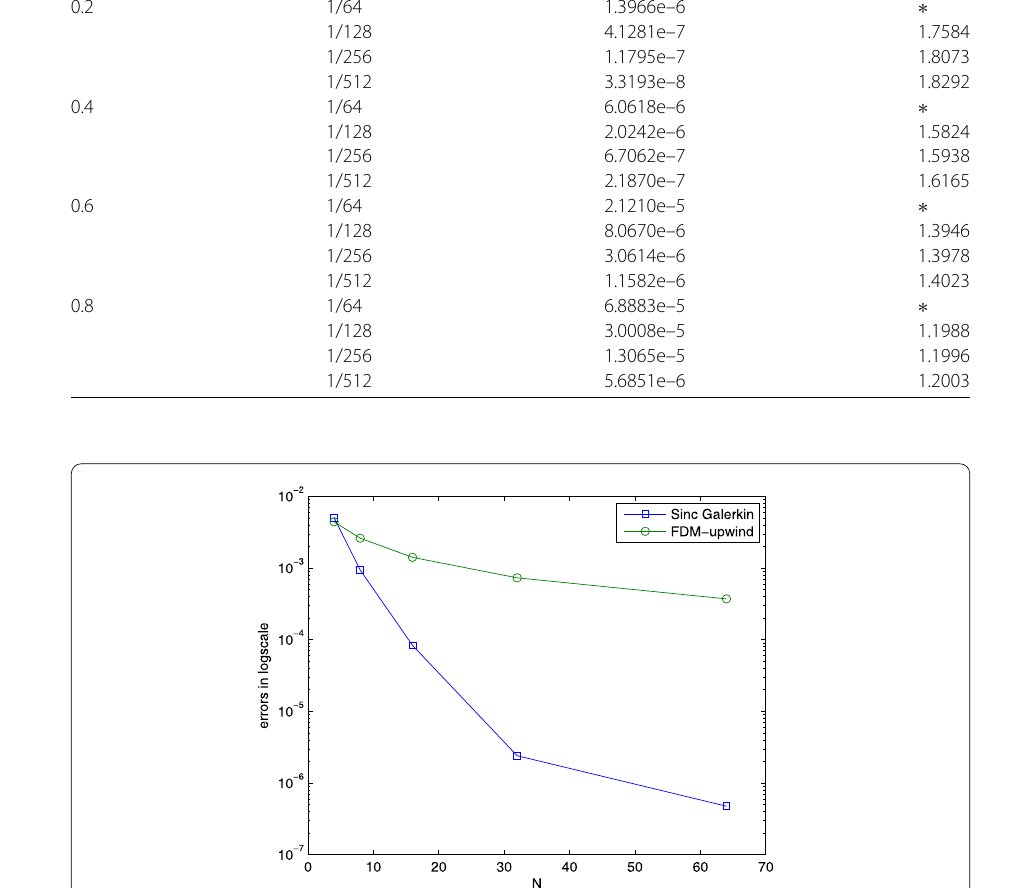
Table 1 The maximum absolute errors and temporal convergence orders with N = 64 α τ e ∞ ( h , τ ) rate 1 0.2 1/64